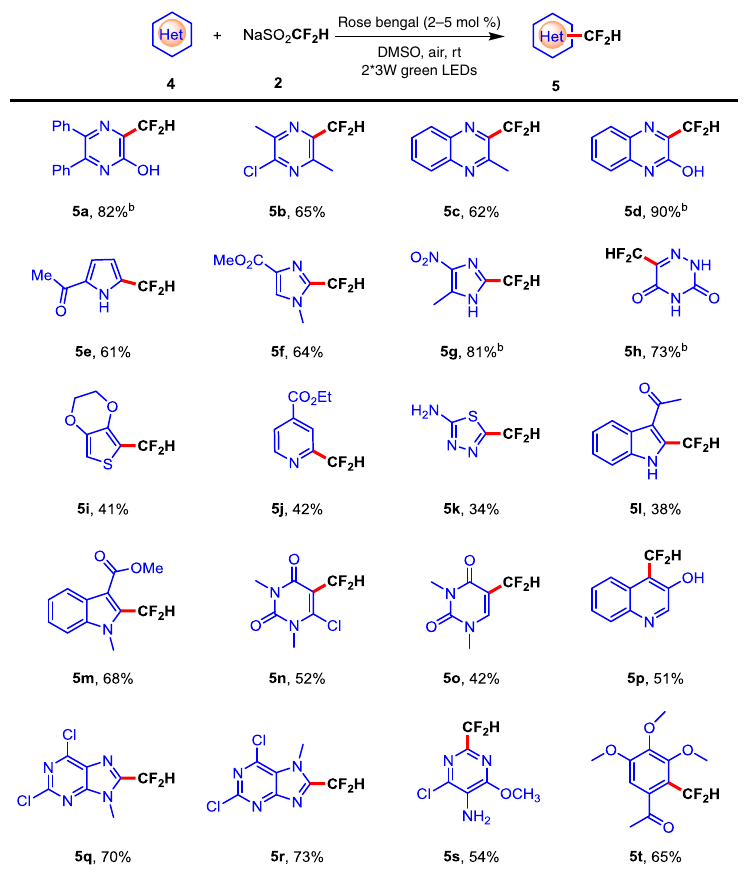
Fig. 3 Substrate scope of heteroaromatics. Reaction conditions: 4 (0.1 mmol), CF 2 HSO 2 Na 2 (0.4 mmol), rose bengal (5 mol.%) in 1 mL DMSO under two 3 W green LEDs irradiation at room temperature. Isolated yields based on 4 . b With CF 2 HSO 2 Na 2 (0.4 mmol), rose bengal (2 mol%) in 1 mL